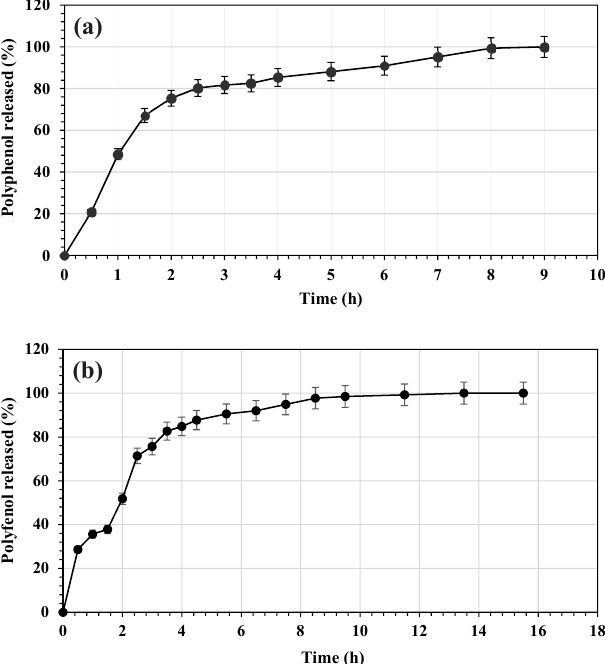
Fig. 5. In vitro release profile of MD-APPE NPs at pH 4.5 (a) and 6.8 (b).